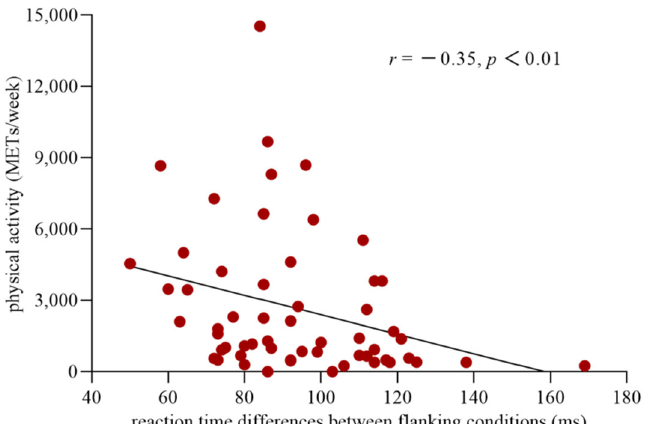
Figure 3. Correlation between the efficiency of the executive control network and the level of physical activity. The abscissa shows the reaction time differences between the incongruent and congruent conditions, which reflect the efficiency of executive control network, and the ordinate indicates the level of the physical activity.